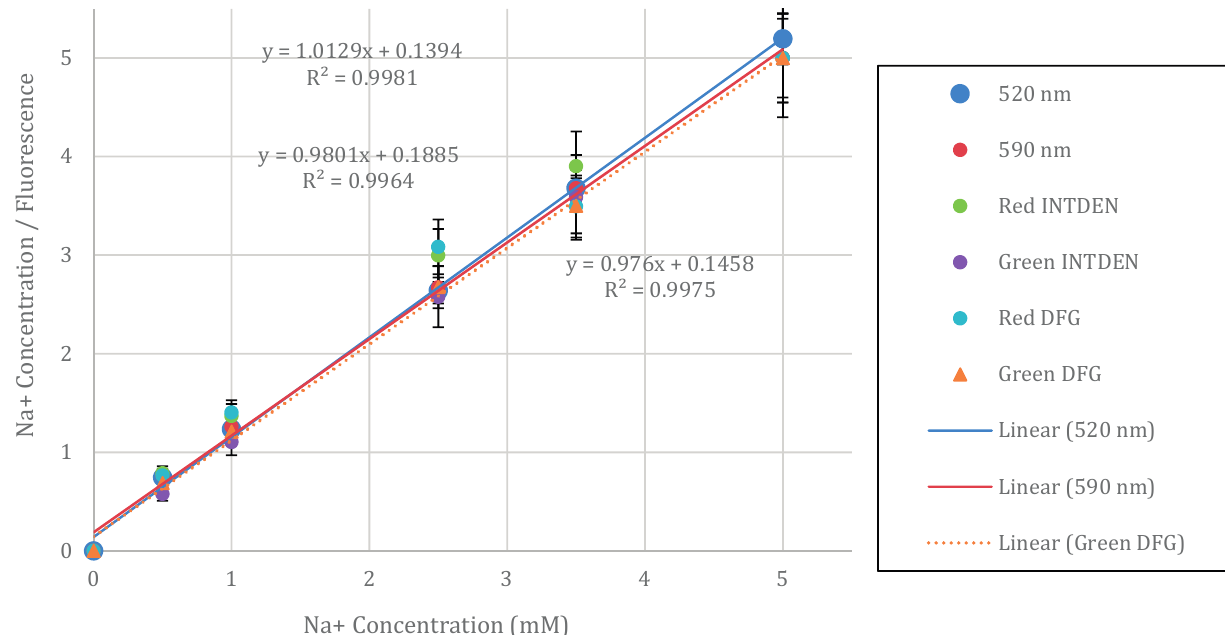
Figure 4. Linearized plot of fluorescence with a 520-nm (top equation and R 2 value) and 590-nm emission filter (equations to the left of the lines and R 2 value are measured using the manufacturer’s supplied software, FluoroPLUS, TiterTek Instruments, Huntsville, AL, 2009). The other data represent the red and green integrated intensity values as measured using the integrated density of the red image channel (RED INTDEN) and the same area for the green image channel (GREEN INTDEN). Data where a holographic grating is used in front of the camera lens are designated as Red DFG and Green DFG respectively. The dotted trend line and lower-right equation are for the Green DFG, which had the best correlation when compared to the microplate reader, especially at the lower sodium ion concentrations. Relative fluorescence readings are determined based on normalizing with respect to the fluorescence measured at a 10 mM initial sodium ion concentration for each instrument. Simulated saliva (SS1) is used for the data at a 5 mM Na ion